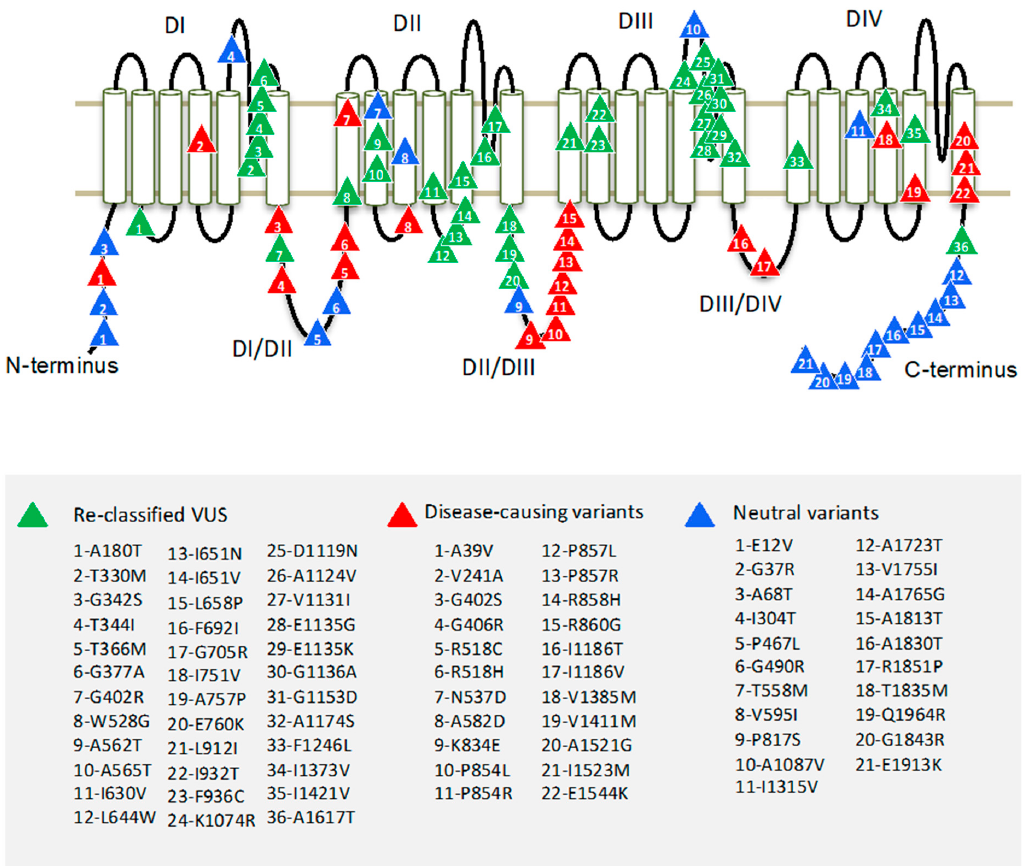
Figure 1. Topology of the hCav1.2 channel. Four repeat domains (DI–DIV) are connected by intracellular linkers. Each domain contains six transmembrane segments (S1–S6). Variants of uncertain clinical significance, which are reclassified here as P/LP variants, are marked by green triangles; known P/LP variants are marked by red triangles; and benign variants are marked by blue triangles.